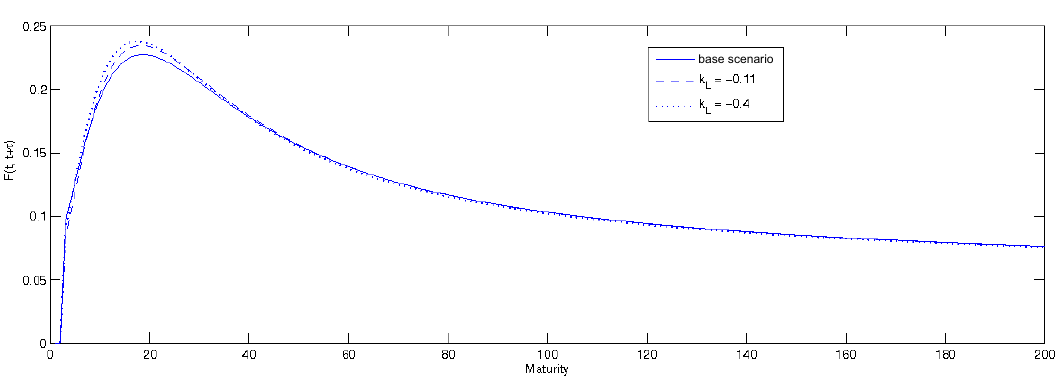
Figure 20. Forward yield when parameters k z , k η , and k L